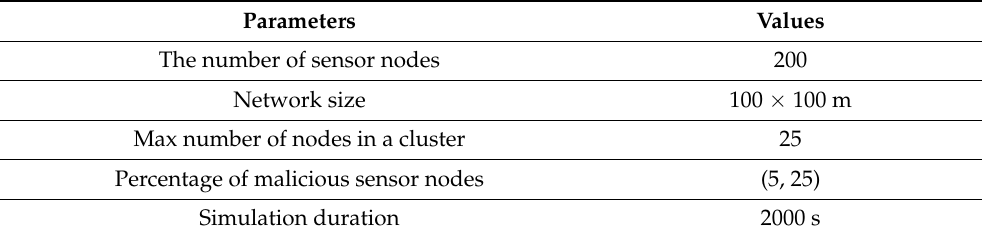
Table 2. The simulation parameters. Parameters